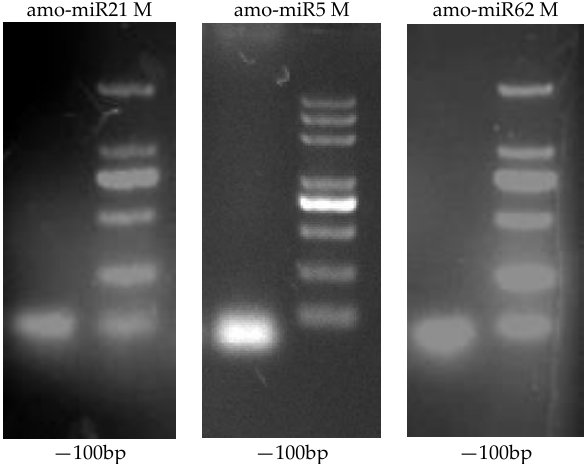
Figure 8. RT-PCR amplification of pre-miRNAs in transgenic plants. Note: M: 100 bp of ladder DL2000 (TIANGEN, Beijing,